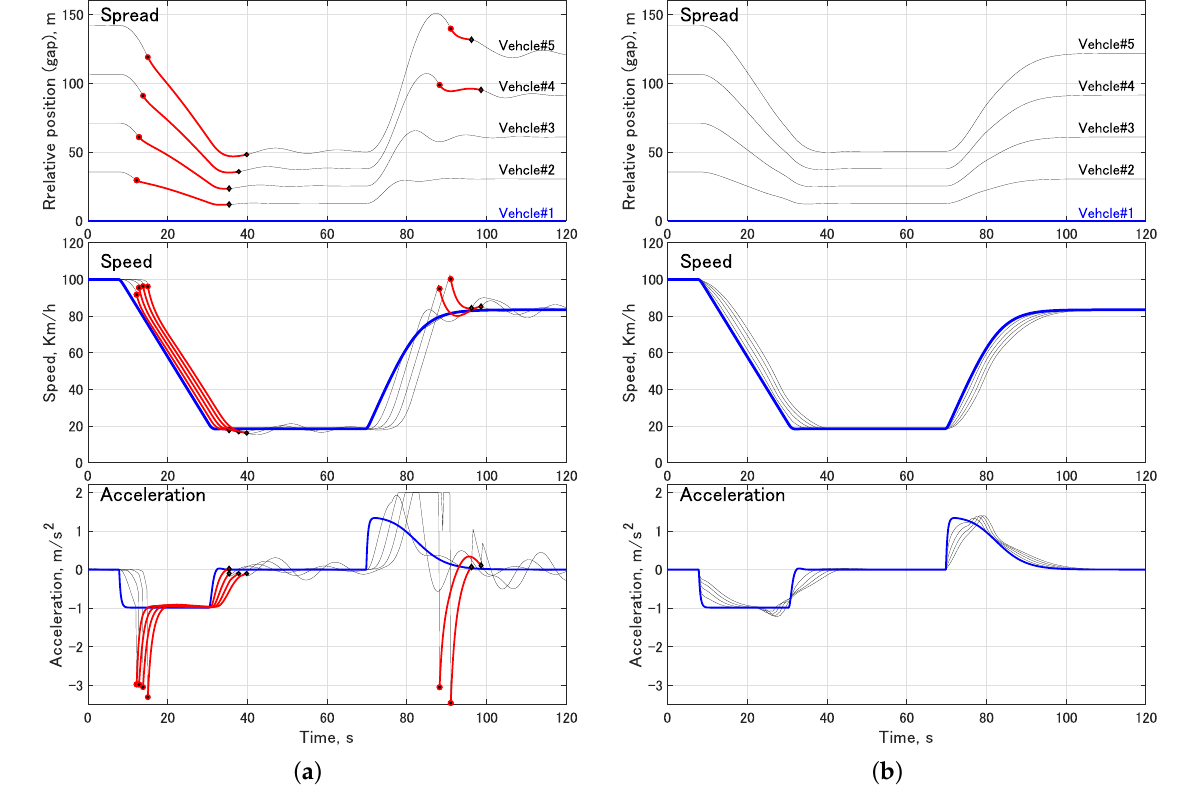
Figure A1. Flowing behavior of five vehicles when the first vehicle brakes and later accelerates at a moderate level, and the rest of vehicles are controlled by ( a ) ACC and ( b ) La-ACC. The red curves show the deactivation period as they are driven by a human